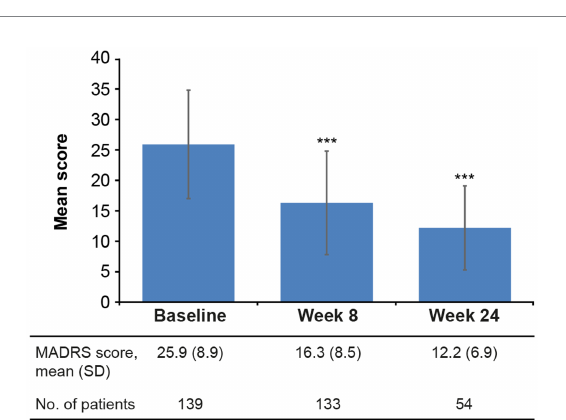
FIGURE 2 Mean (SD) MADRS total score at baseline and after 8 and 24 weeks of vortioxetine treatment (effectiveness analysis set). *** p < 0.0001 vs. baseline. MADRS, Montgomery–Åsberg Depression Rating Scale (score range 0–60); SD, standard